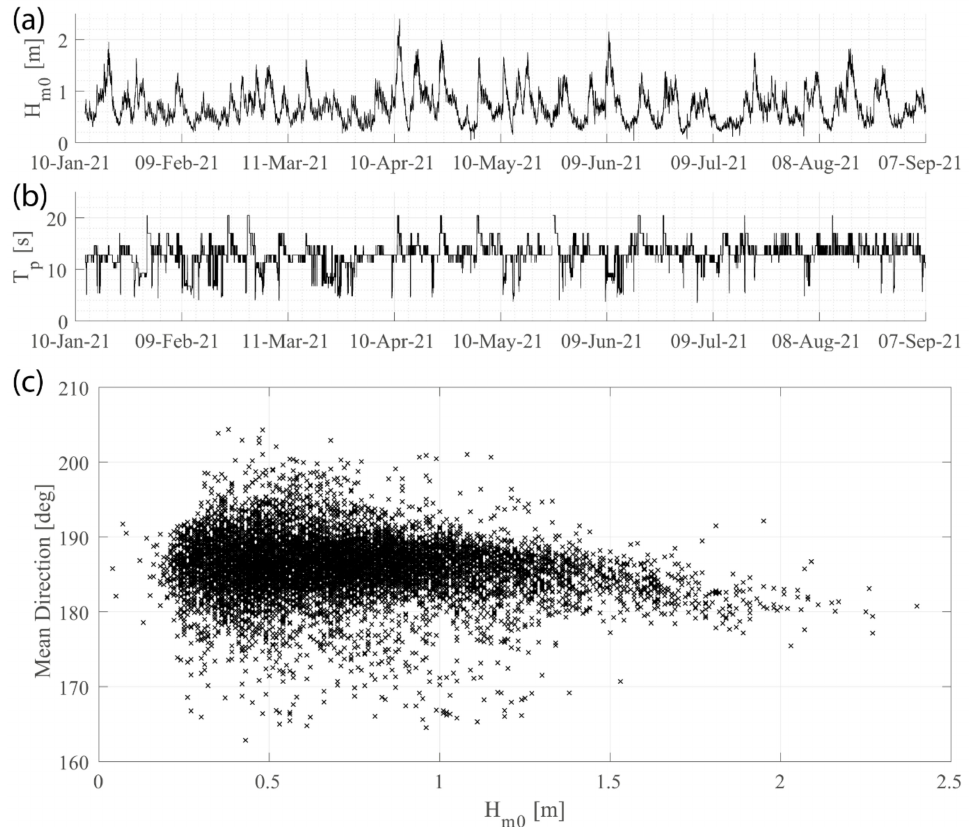
Figure 4. ( a ) Time series of the spectral significant wave height (H m0 ) and ( b ) the peak wave period (T p ) measured at King Island. ( c ) Scatter diagram showing the relationship between the spectral significant wave height and mean wave direction at King Island. Wave measurements undertaken utilizing a Sofar Ocean Spotter buoy between 12 January 2021 and 7 September 2021.